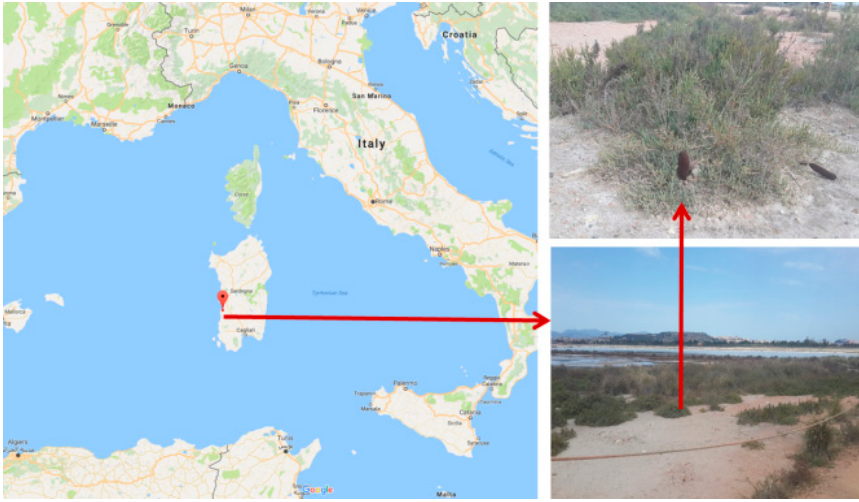
Figure 1. A shoot of Cynomorium ( top right ) growing in the coastal area of Sardinia ( bottom right ) and a map of Sardinia indicating the location where the Cynomorium samples used as part of this study were harvested ( left ).